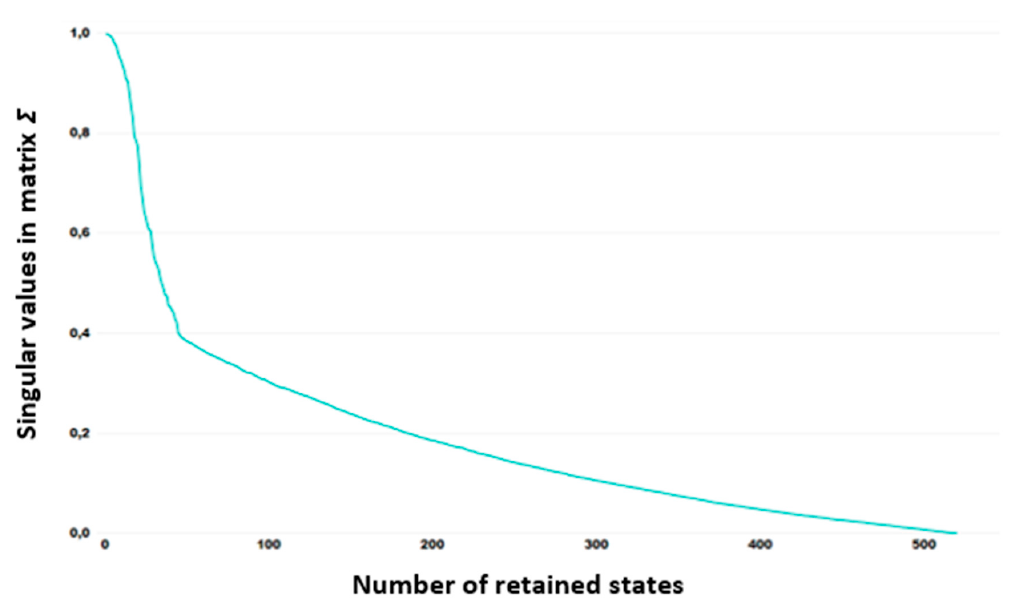
Figure 5. Number of retained states using dominant singular values.